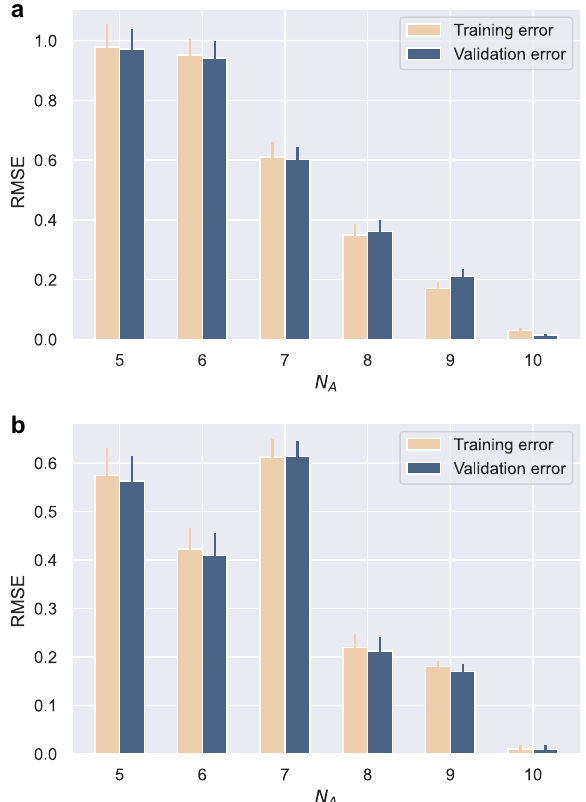
Fig. 3 The RMSE of the MLCP model in estimating the second- order Rényi entropy of varied subsystem sizes. a The model is trained with the sub-dataset of category C 1 given N U = 512, N M = 300. b The model is trained and validated with the sub- dataset of category C 2 given the same measurement settings. The error bar denotes the standard variance of repeated runs with different